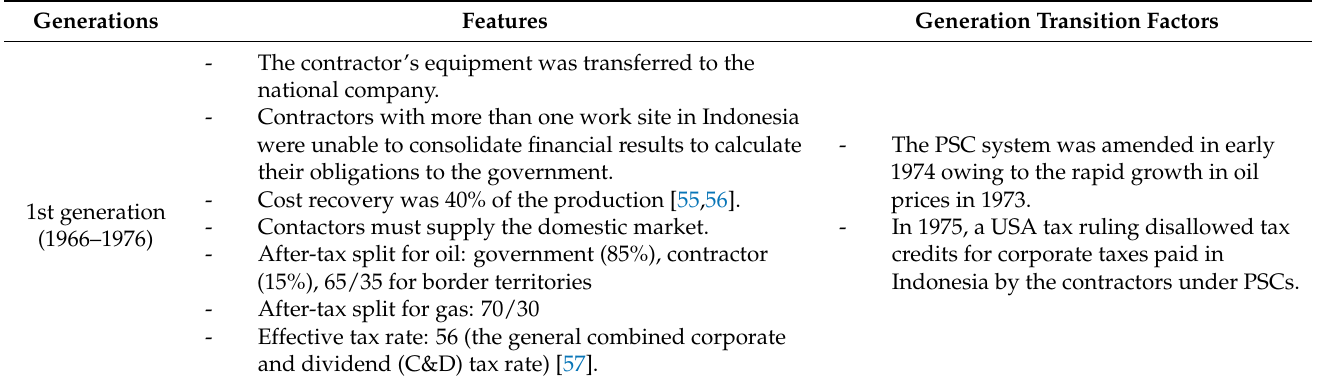
Table 2. Key generation characteristics of PSC contracts in the oil and gas sector (a case study of Indonesia).